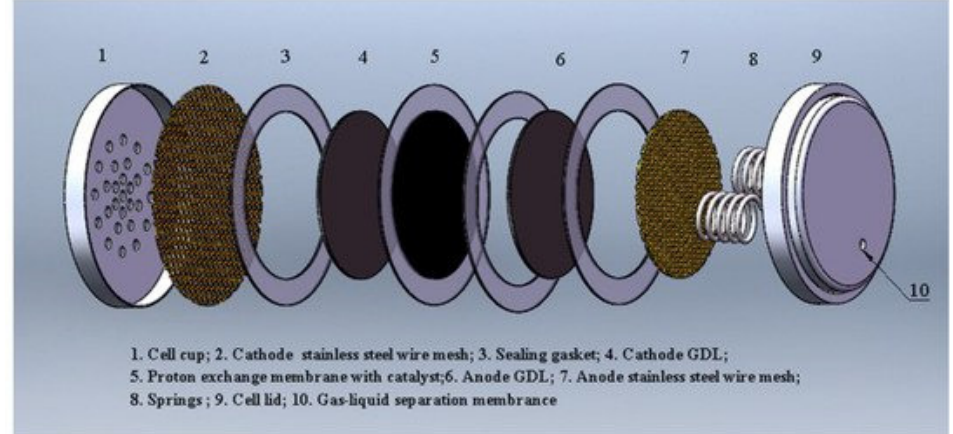
Figure 3. Schematic of a novel button-type PS-DMFC. Reproduced from [92].